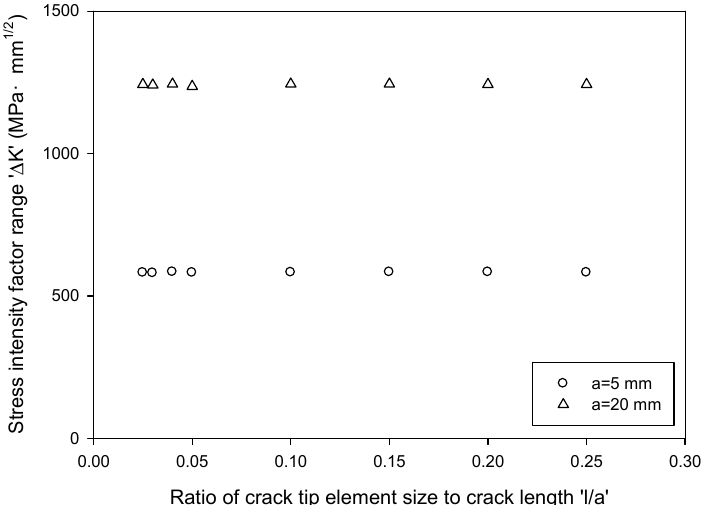
Figure 12. Stress intensity factor versus crack tip element size to crack length ratio.